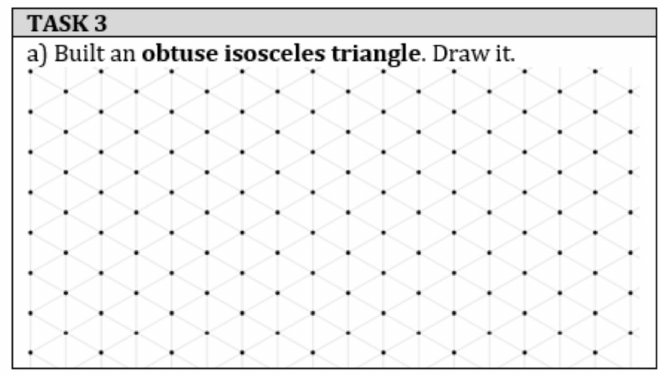
Figure 5. Example of a task in the final interview: draw polygons with certain attributes using an isometric geoplane and explain